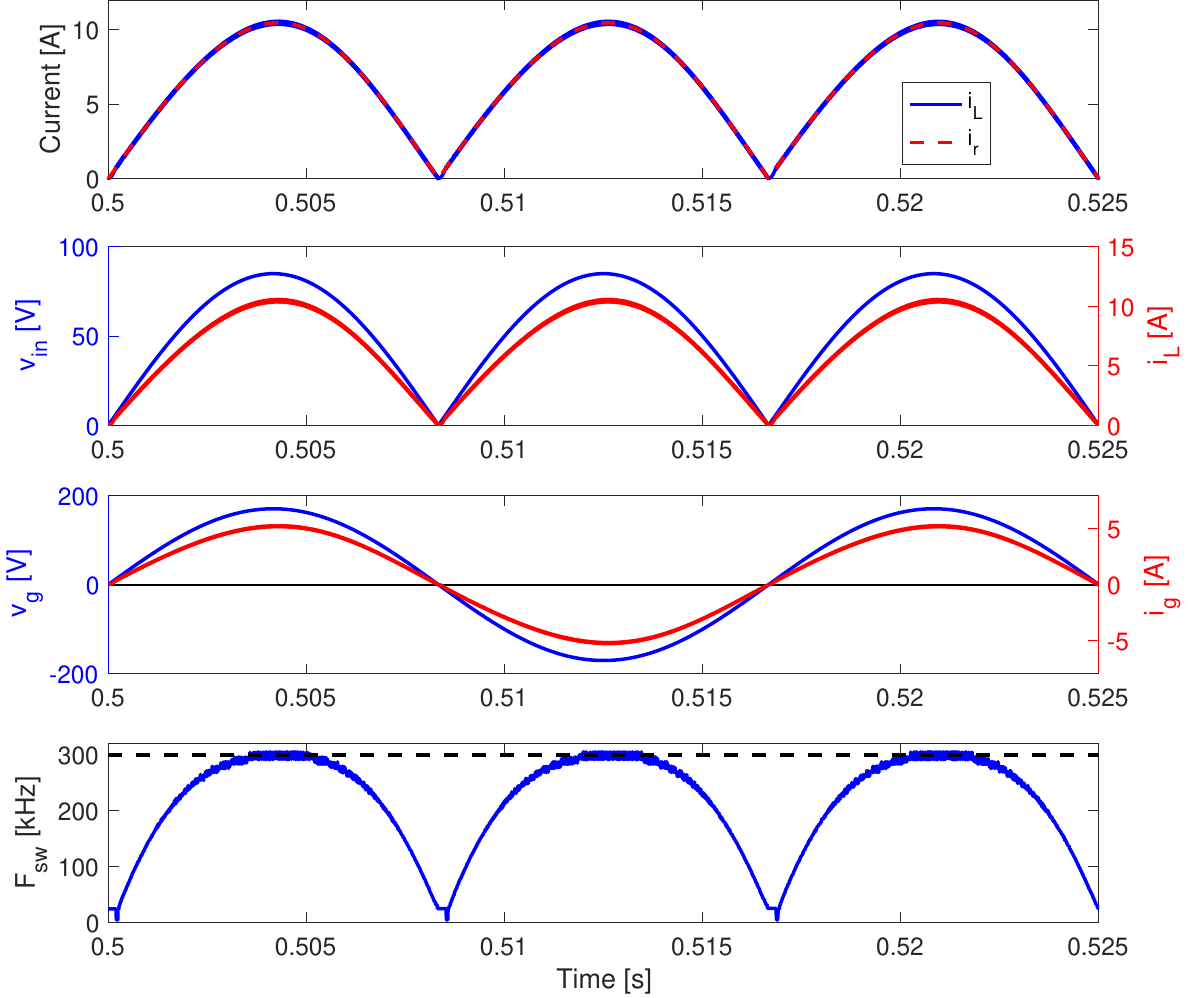
Figure 14. Validation of the SMC, inductor current and hysteresis band. Section 2.3 discussed the possible instability of the rectifier when v in is near to zero, which is confirmed in the zoom presented in Figure 15. Such a figure confirms that the designed value for L ensures that the switching function Ψ is always inside the hysteresis band, thus the inductor current closely follows the reference. The figure also shows the same waveform around v in = v pk , where the switching function is always triangular and inside the hysteresis band. Therefore, this simulation confirms the correct operation of the SMC, and the correct design of L and ∆Ψ